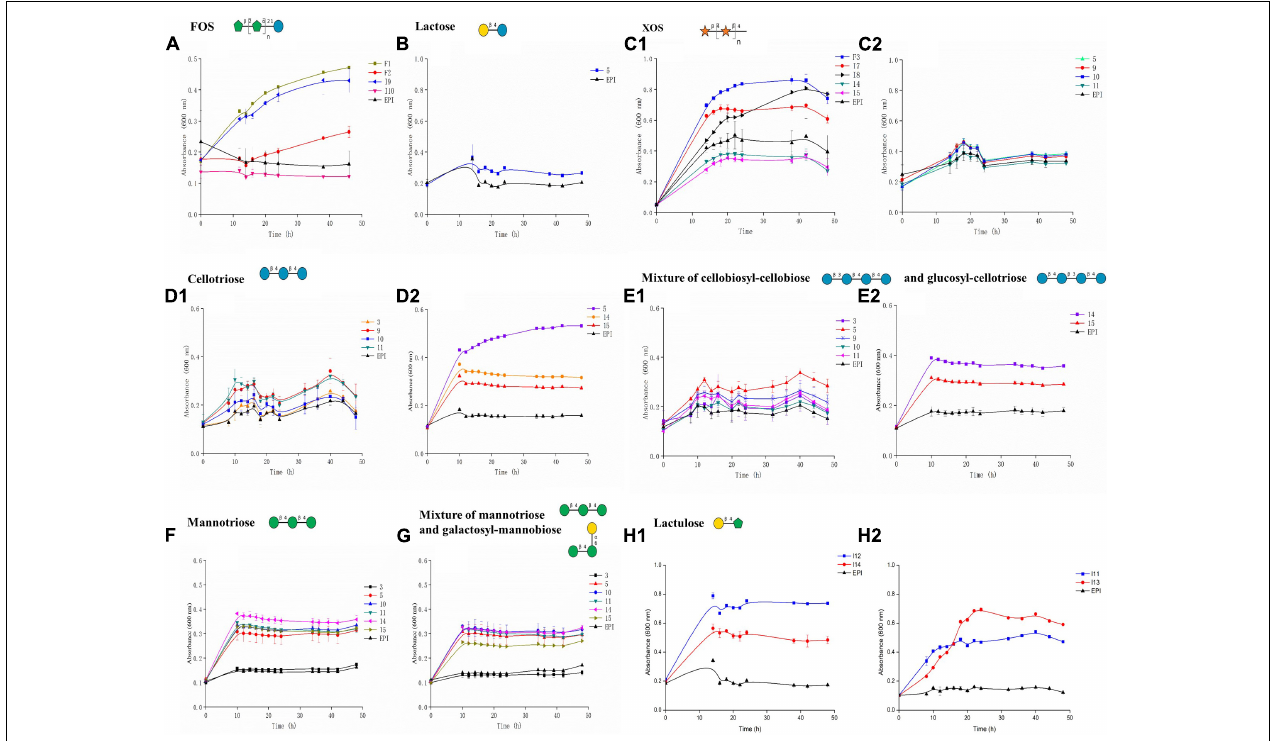
FIGURE 1 | Growth of metagenomic clones on various oligosaccharides used as sole carbon sources: (A) FOS, (B) lactulose, (C) XOS, (D) cellotriose, (E) mixture of cellobiosyl-cellobiose and glucosyl-cellotriose, (F) mannotriose, (G) mixture of galactosyl-mannobiose and mannotriose, and (H) lactulose. The data represent the averages from biological triplicates, and the scale bars represent the standard deviation (SD). TABLE 2 | Number of hit clones obtained from different libraries and hit yield in growth